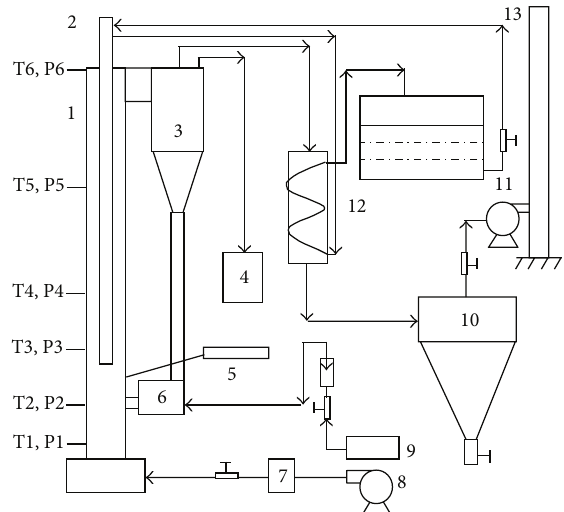
Figure 1: Test facilities of the CFBC pilot: 1, furnace; 2, water tube; 3, cyclone; 4, gas analyzer; 5, fuel screw feeder; 6, U-valve; 7, primary air meter; 8, forced draft fan; 9, air compressor; 10, bag filter; 11, induced draft fan; 12, economizer; 13, stack; T1–T6, thermocouples; P1–P6, pressure